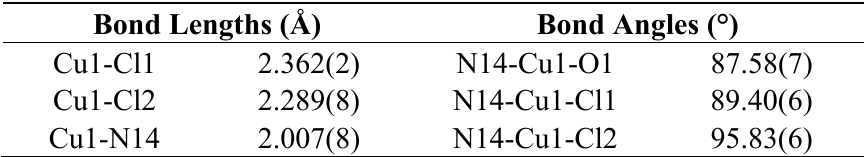
Table 4. Selected bond lengths and bond angles in copper complex 7